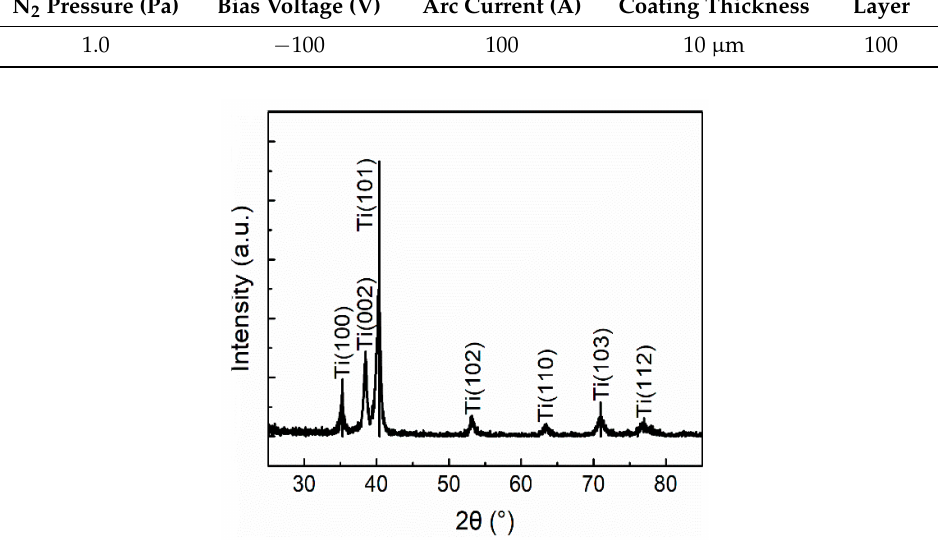
Figure 1. XRD diffractogram of TiN /ZrN